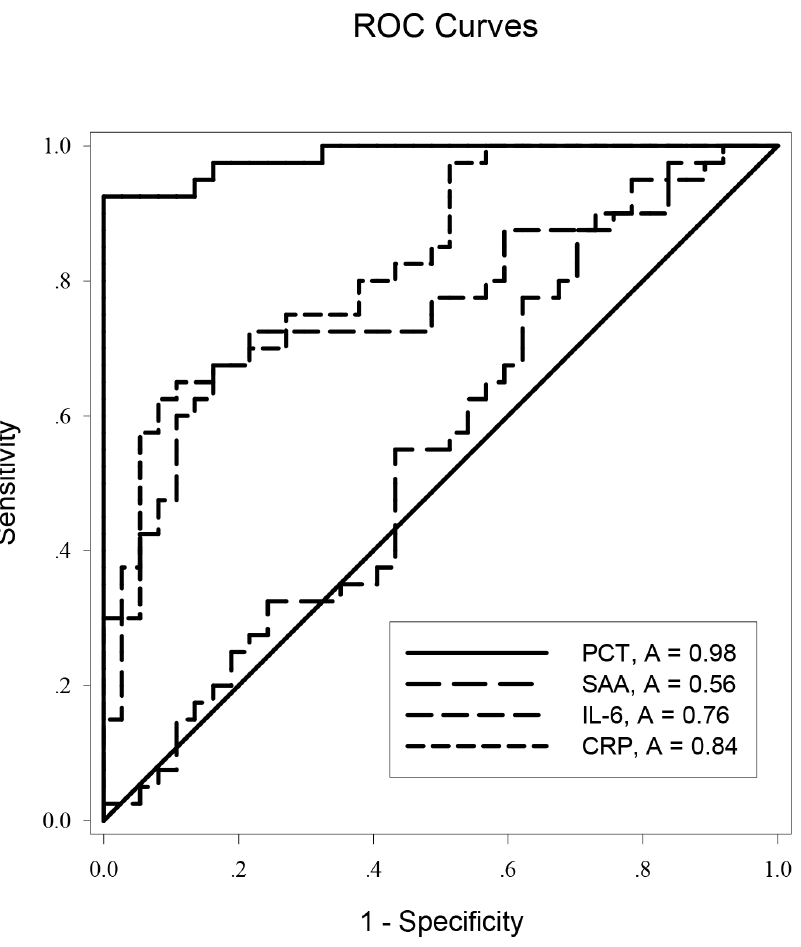
Figure 2. Receiver operating characteristic (ROC) curves for PCT, SAA, IL-6, and CRP for predicting AKI in AP.